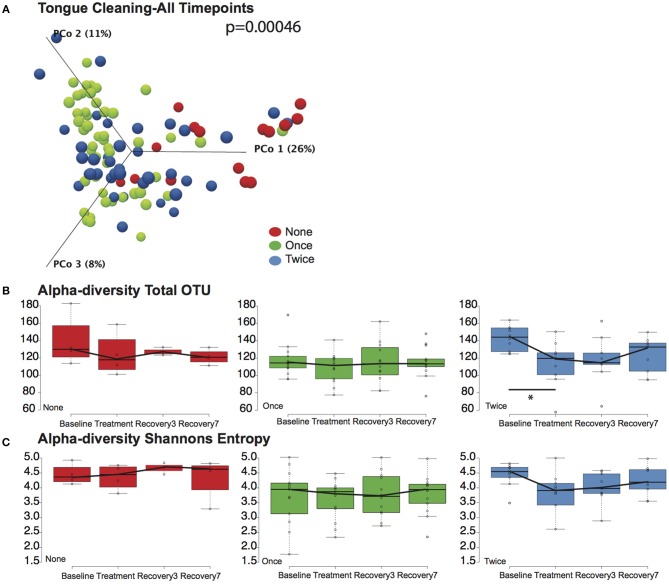
Effects of tongue hygiene and chlorhexidine exposure on community diversity and composition. (A) Bray-Curtis Principle component plot of bacterial communities across all time points, colorized by tongue cleaning frequency. The distribution between cohorts remains distinct; the PERMANOVA p-value is 0.00046. (B) Community richness as measured by Total OTUs. Only the two-cleaning per day cohort, shown in blue, had a significant change in richness after CHX treatment as noted by the asterisk. (C) Community diversity as measured by Shannon entropy. No significant differences were noted for any cohort.